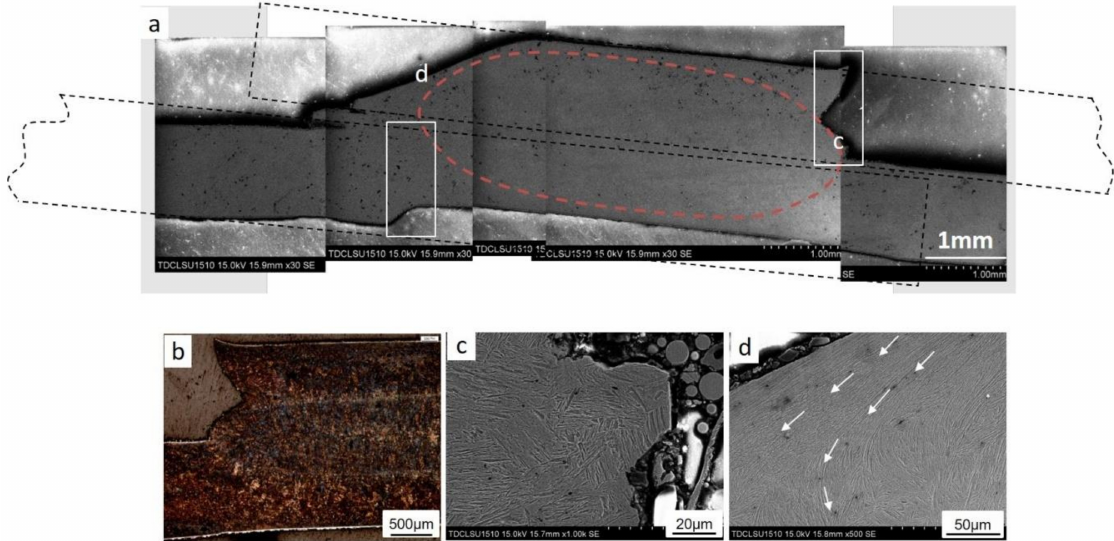
Figure 8. Button-shape fracture images, obtained at AC-6, with a peak current of 12.7 kA, frequency of 110 Hz, and welding time of 35 cycles: ( a ) overall view of a fractured joint, ( b ) optical image showing nugget, ( c ) SEM image of fracture edge at “c” point, ( d ) SEM image of fracture edge at “d”